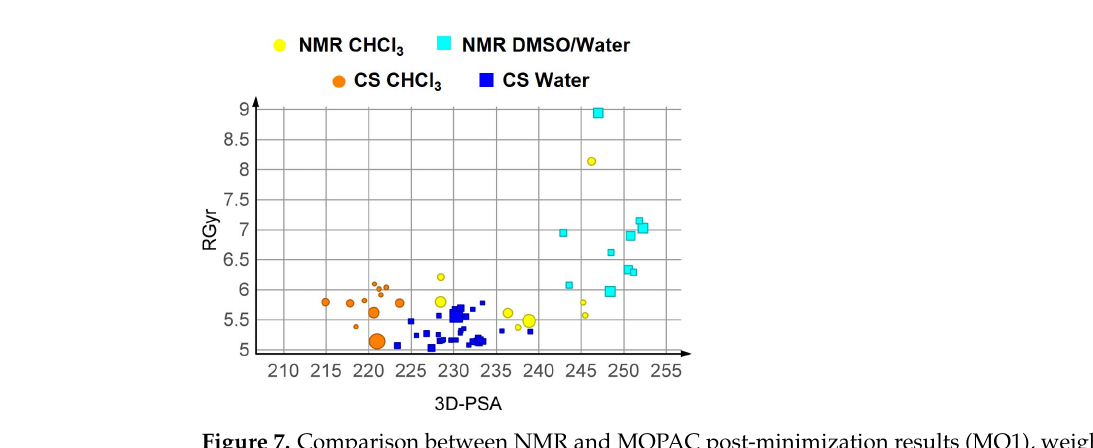
Figure S2: IMHBs pattern in the two solvents; Table S1: Two-dimensional descriptors calculated for PROTAC-1; Table S2: Data resulting from the conformational sampling protocols; Table S3: Data resulting from the post